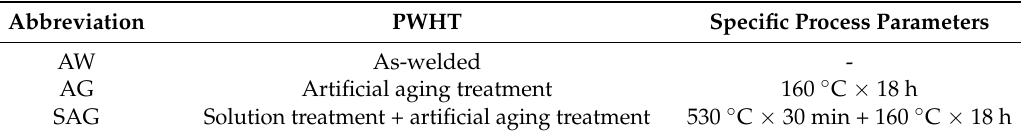
Table 3. Post-weld heat treatment (PWHT) parameters.